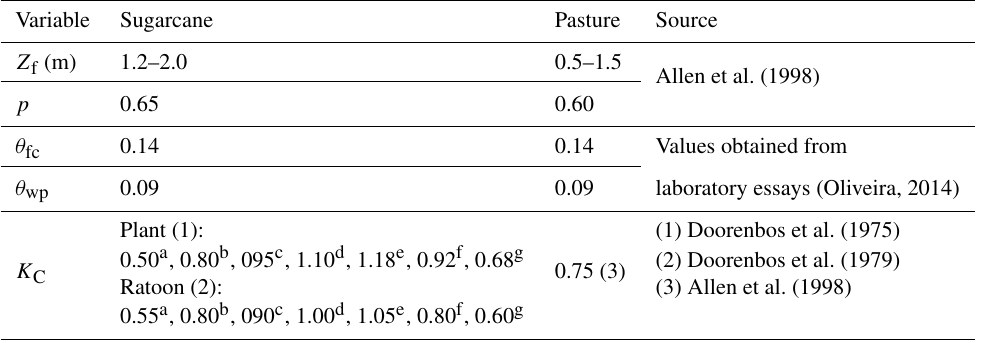
Table 2. Variables used to calculate evapotranspiration for sugarcane and pasture. Variable